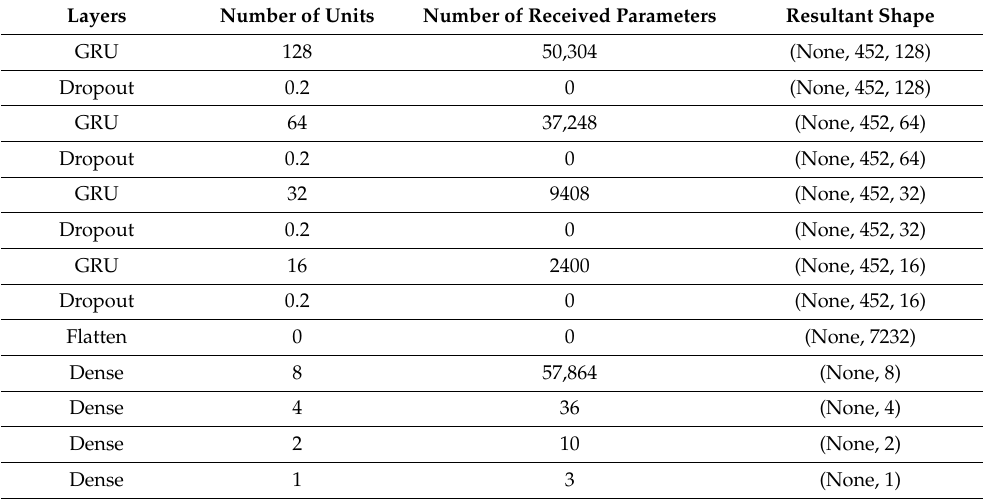
Table 5. Details of the GRU model.